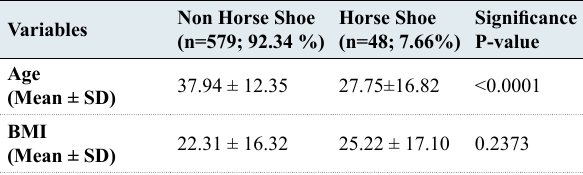
Table 2: Characteristics of study population and stones Variables